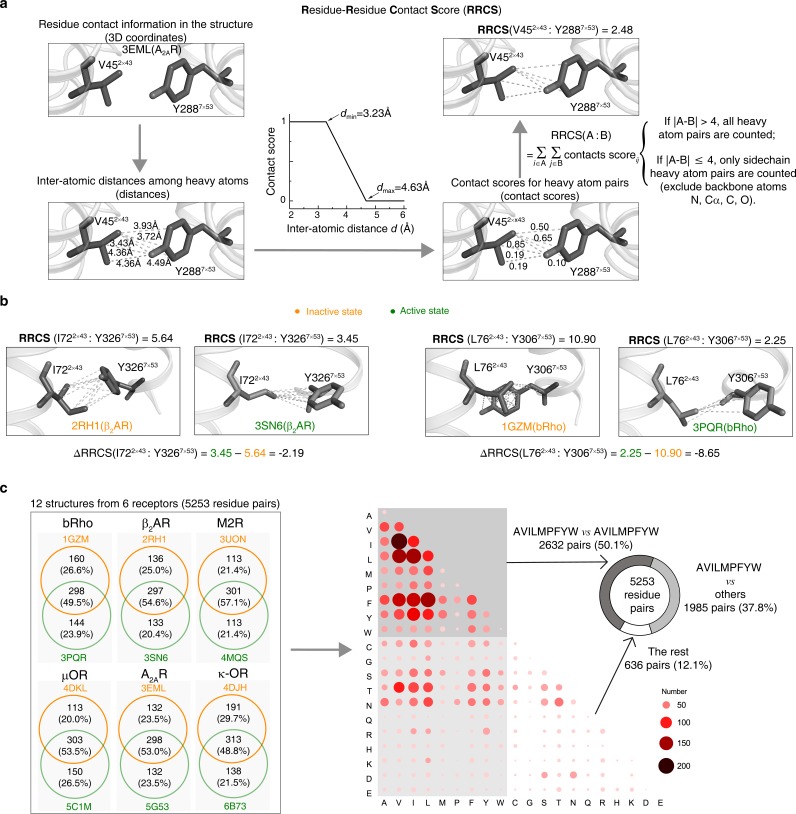
Calculation of RRCS and ΔRRCS.(a) Workflow of RRCS calculation. (b) Examples of RRCS and ΔRRCS calculation for two residues pairs. (c) Statistics of residue contacts and contact types for six receptors (bRho, β2AR, M2R, µOR, A2AR and κ-OR) in their inactive and active states. Contact type describes physicochemical properties of two interacted amino acids that form a pair. The amino acids with hydrophobic side chains (one-letter code: A, V, I, L, M, P, F, Y, W) contribute to the majority of residue contacts, either within themselves (50.1%) or with other amino acids (37.8%).